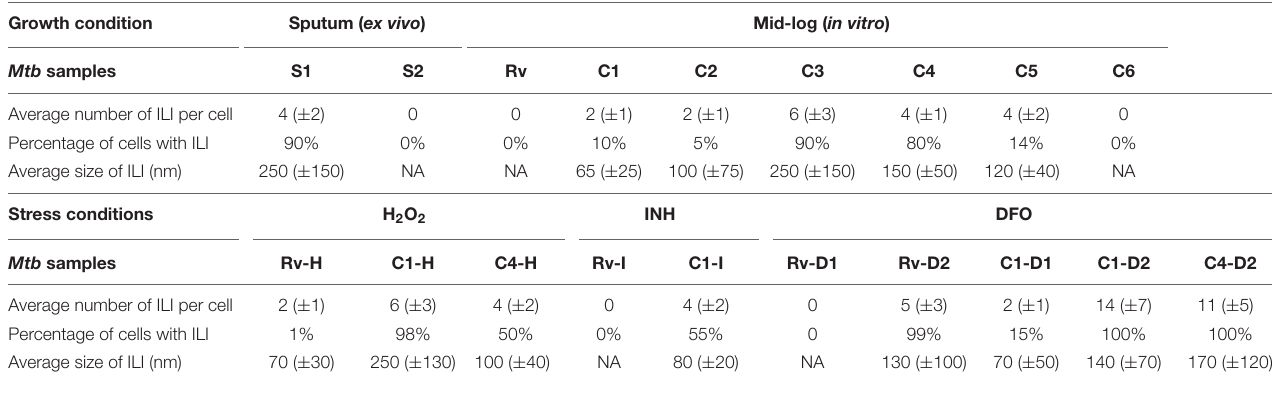
TABLE 2 | Quantification of intracytoplasmic lipid inclusions (ILI) in M. tuberculosis isolates from the study ( n ∼ 100 cells in each isolate/condition, except S2, n = 10 cells). Growth condition Sputum ( ex vivo